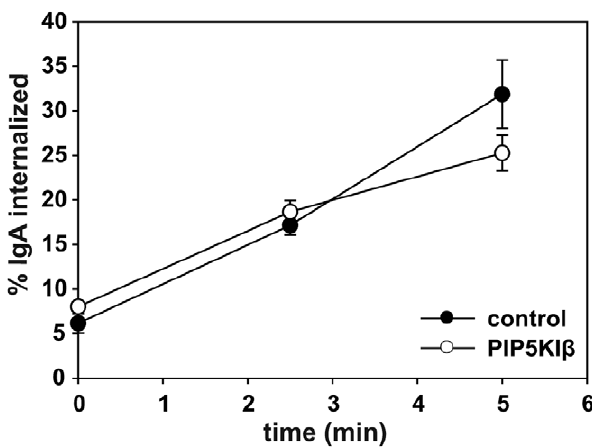
Figure 7. Recombinant ENTH and PTB domains bind to PtdIns(4,5)P 2 -containing liposomes with similar affinities. In- creasing concentrations of PTB-GST or ENTH-GST (the PtdIns(4,5)P 2 binding domains of Dab2 and epsin, respectively) were incubated with control or PtdIns(4,5)P 2 -containing liposomes at ambient temperature for 30 min. The liposomes were pelleted and aliquots of the supernatant and pellet were analyzed by Coomassie staining after SDS-PAGE. The protein recovery in the pellet was quantified by scanning densitometry. Neither domain bound significantly to control liposomes (triangles), and there is no significant difference in the dose dependence of ENTH or PTB binding to PtdIns(4,5)P 2 -containing liposomes (circles). Data represent the combined results from three independent experiments performed using different protein concentra- tions. The mean + / 2 SE or range is plotted for data from multiple